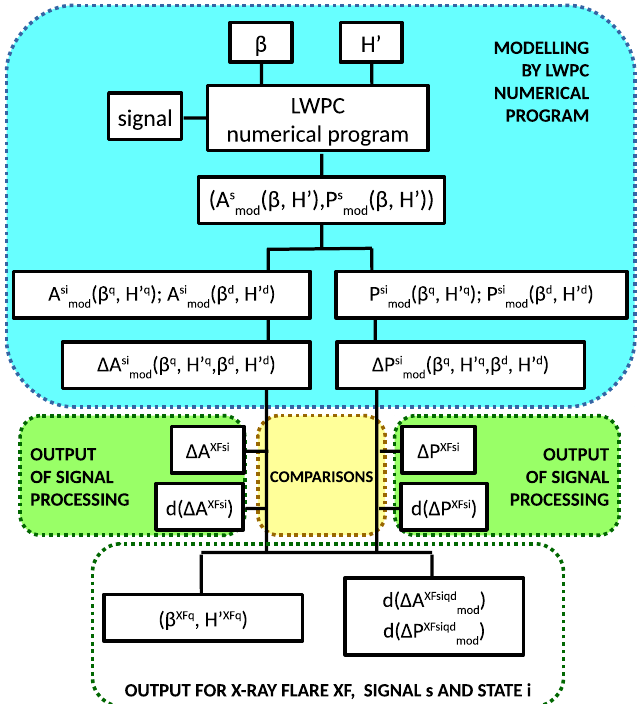
Figure 3. Diagram of sub-procedure